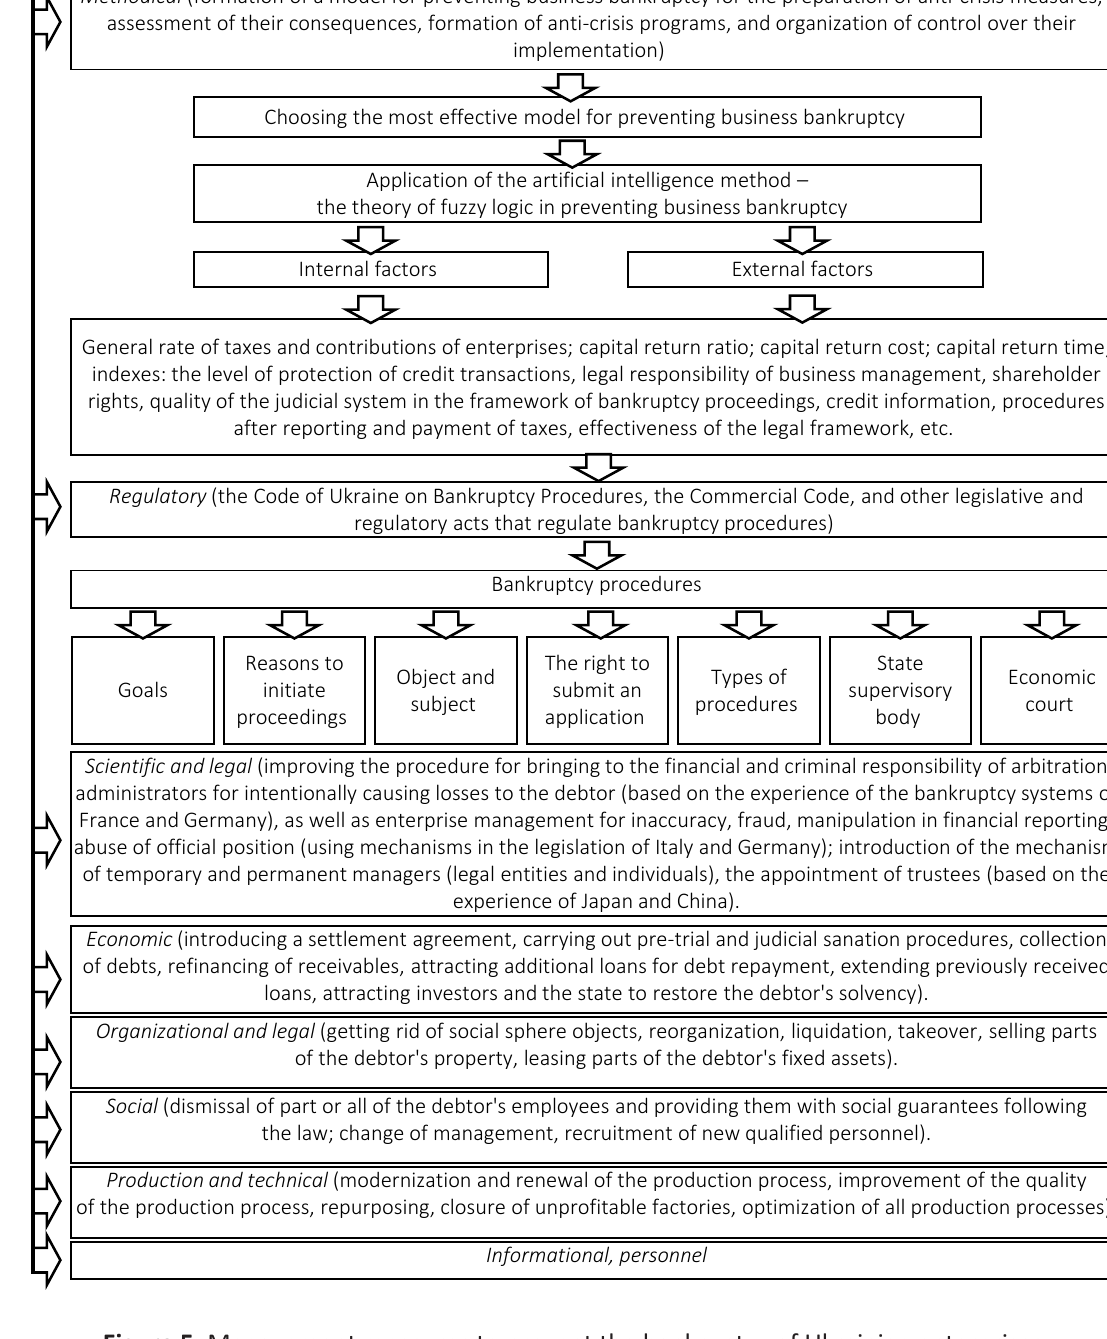
Figure 5. Management measures to prevent the bankruptcy of Ukrainian enterprises under the force majeure